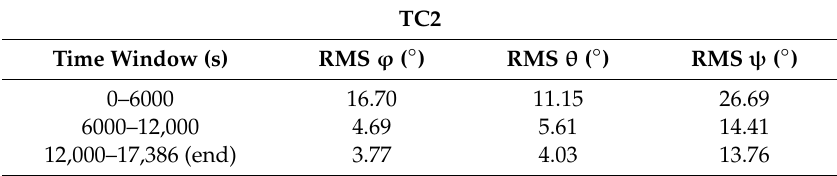
Figure 8. Di ff erence between the actual and estimated Euler angles for Test Case 2 in the range ± 30 ◦ . Figure 8. Difference between the actual and estimated Euler angles for Test Case 2 in the range ±30°. Table 5. Root Mean Square of attitude estimation errors for Test Case Figure 8. Difference between the actual and estimated Euler angles for Test Case 2 in the range ±30°.